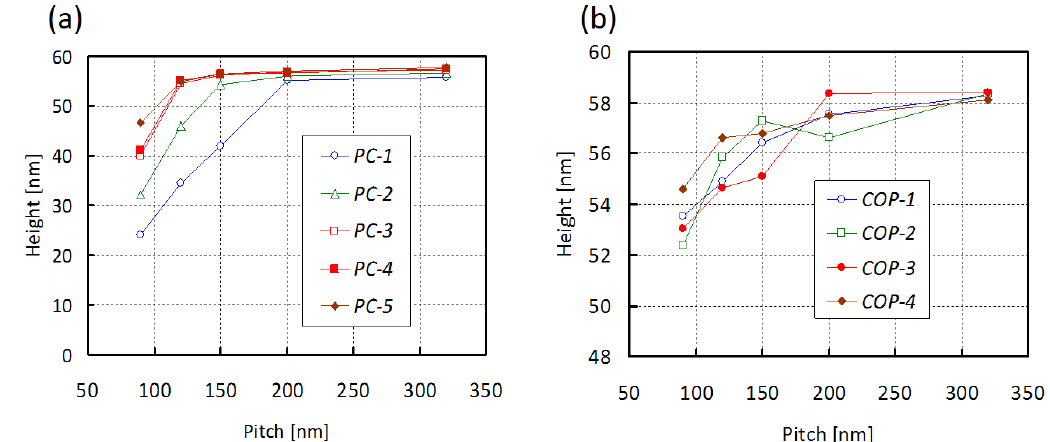
Figure 3. Pattern heights of injection-compression-molded replicas of samples ( a ) PC-1-5 and ( b ) COP-1-4 obtained by atomic force microscopy (AFM) analyses as a function of pattern